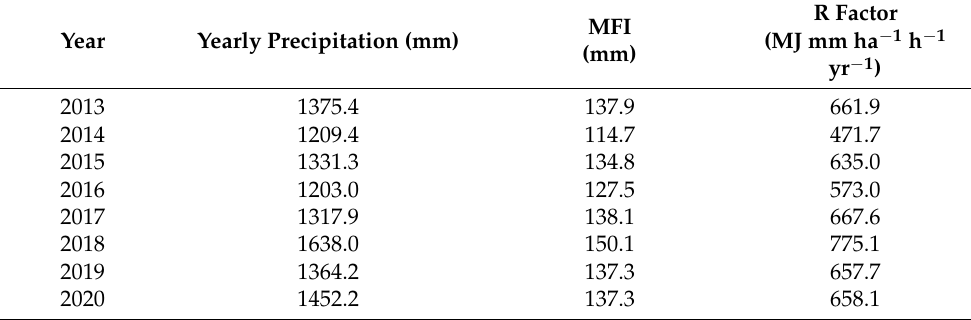
Table 4. Estimated annual mean R factor values from